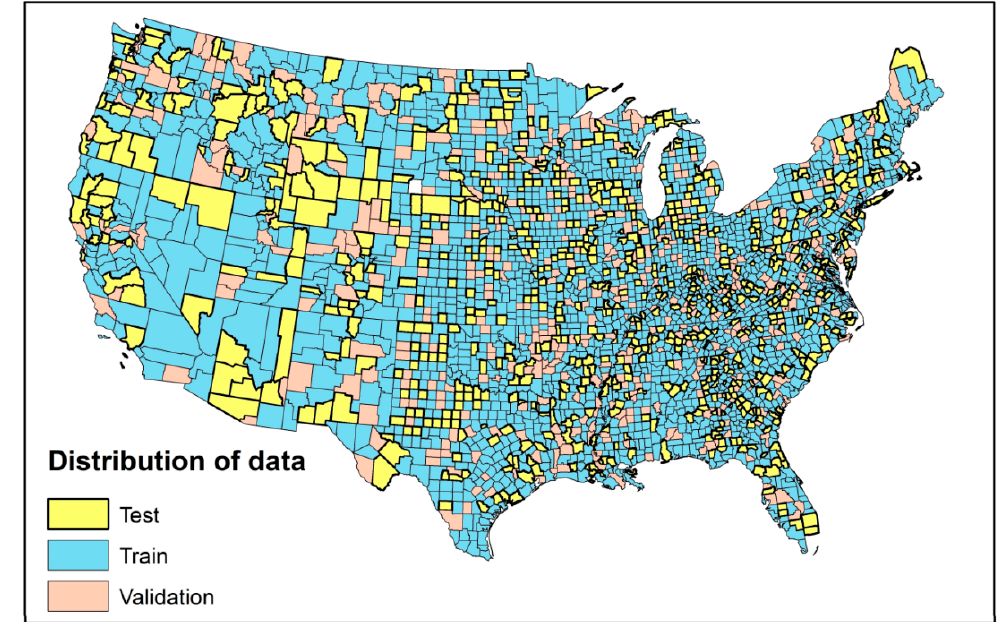
Figure 2. Spatial distribution of training, cross-validation, and test data used for modeling log (STIR).